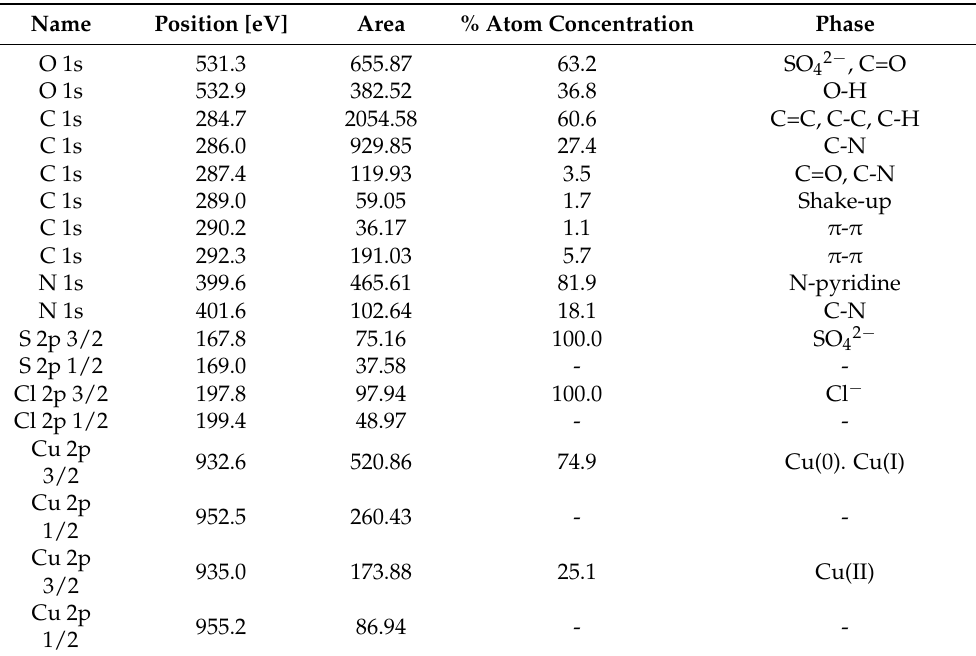
Table 9. The results of XPS analysis obtained in a narrow range of binding energy for Dowex M 4195 after Cu (II)